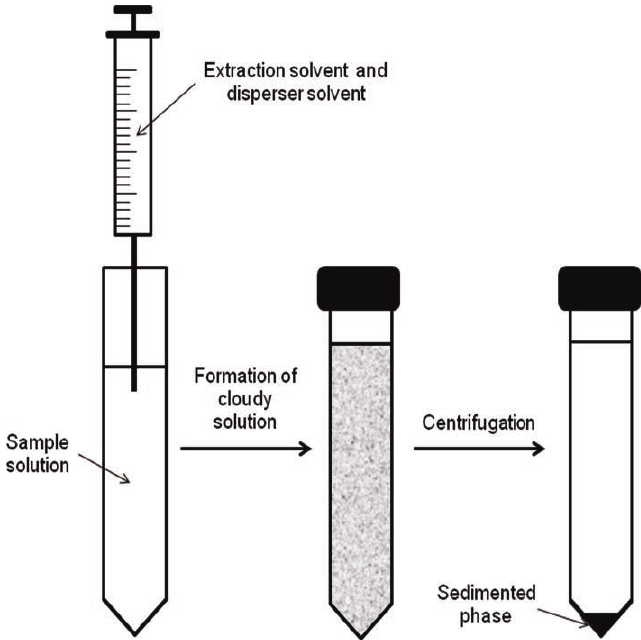
Figure 6. Schematic diagram of DLLME